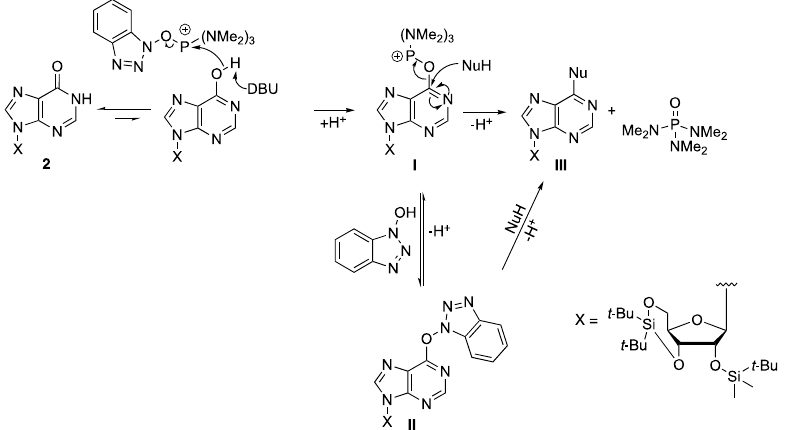
Figure 1. Proposed mechanism for BOP-mediated S N Ar [11].